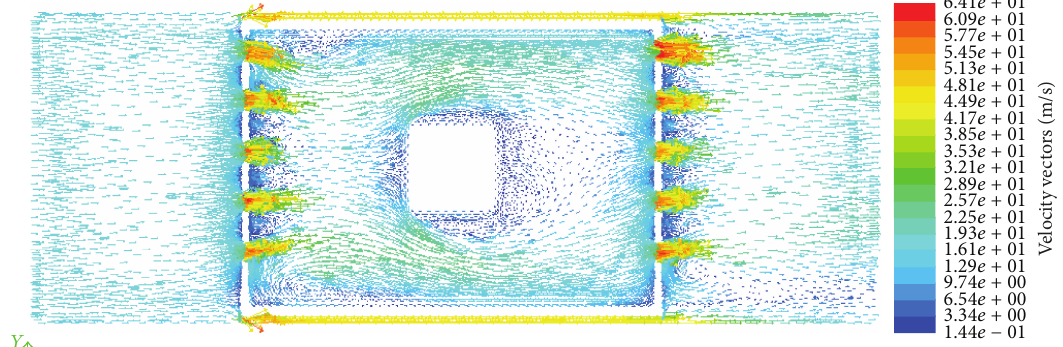
Figure 15: Velocity vector distribution of the round hole in the section 𝑍 = 0 .